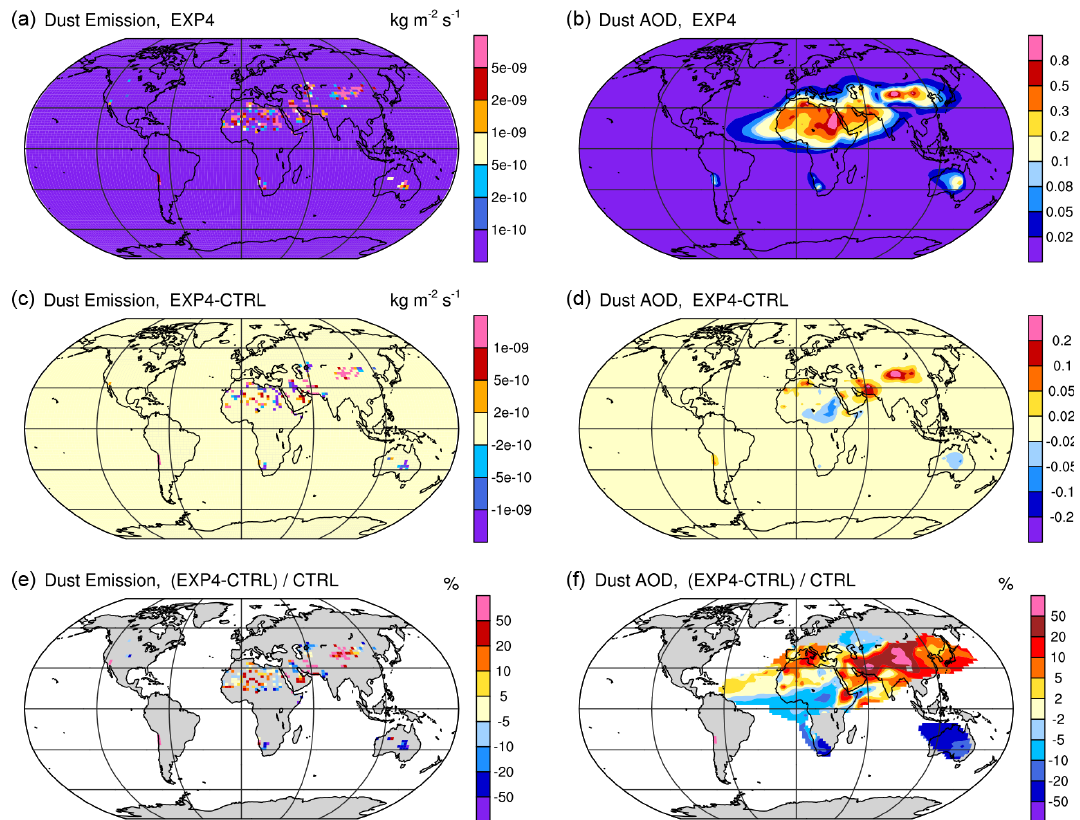
Figure 18. Top row: year 2006 mean dust emission flux (kgm − 2 s − 1 ) and dust AOD (unitless) at 550nm in EXP4; Second row: differences between EXP4 and CTRL. Bottom row: relative differences between EXP4 and CTRL. In the bottom row, locations that have emission fluxes less than 1 × 10 − 10 kgm − 2 s − 1 or AOD < 0 . 01 in the CTRL simulation are masked